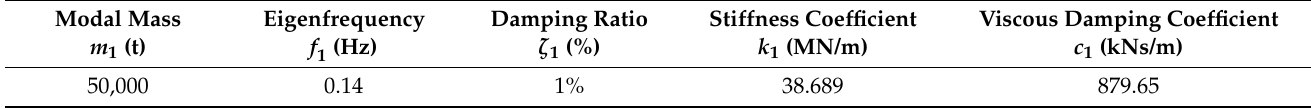
Table 1. Assumed primary structure modal parameters.